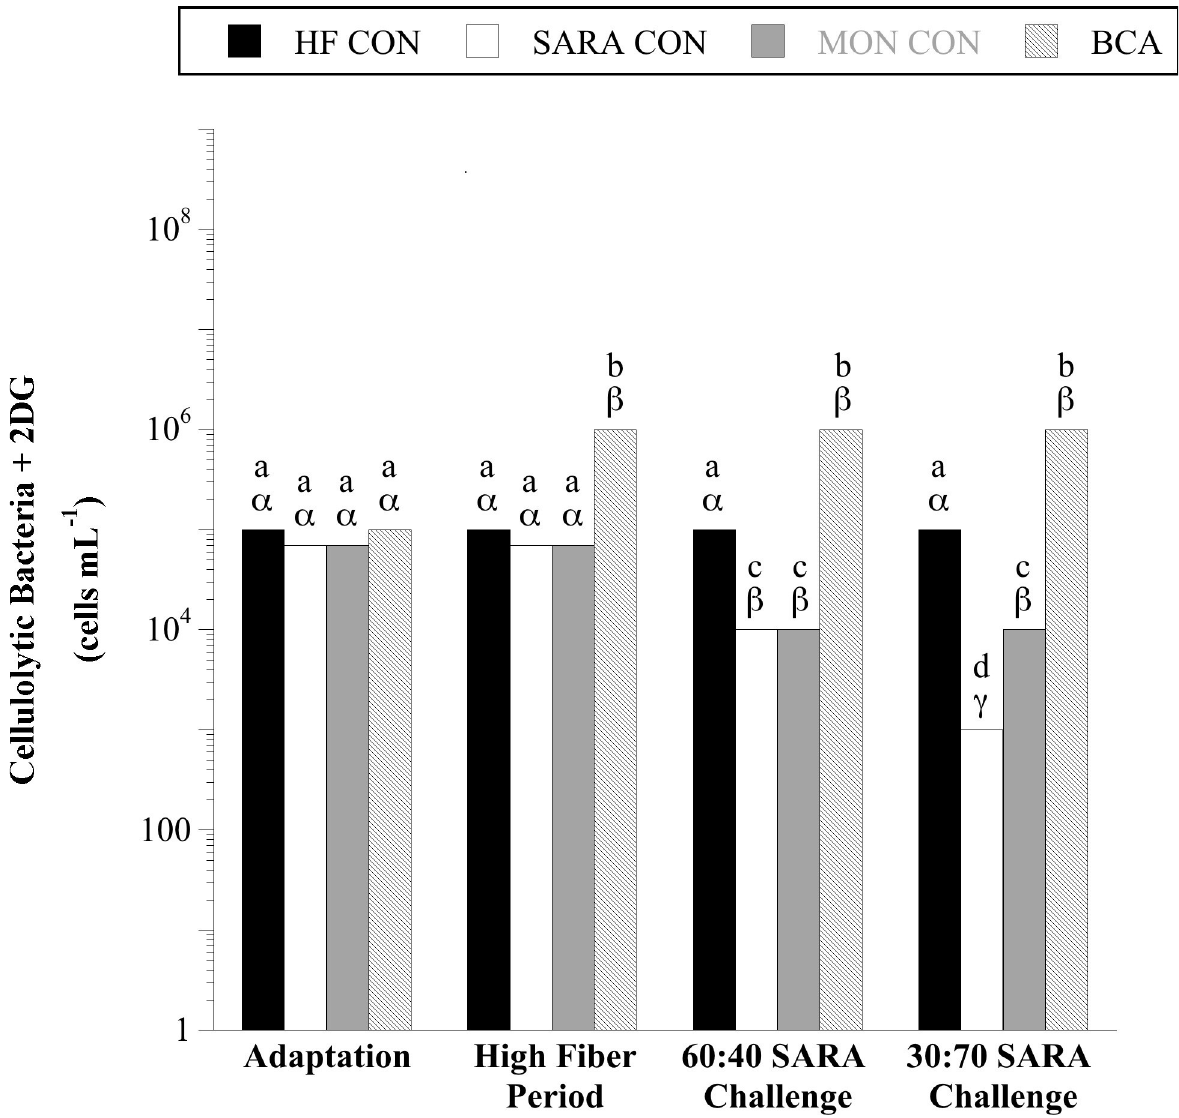
Fig 5. Effect of biochanin A on the viable number of 2-deoxy-D-glucose (2-DG) resistant cellulolytic bacteria in rumen fluid (4 h post- feeding). Holstein steers (n = 12) were blocked by weight into 1 of 4 treatments: High fiber control (HF CON; basal diet control, corn silage + dried distillers’ grain, to meet protein requirements; n = 3), SARA control (SARA CON; n = 3), SARA + monensin treatment (MON CON; 200 mg d -1 monensin; n = 3), or SARA + biochanin A treatment (BCA; 6 g d -1 biochanin A; n = 3). Rumen fluid samples were taken at the end of the adaptation period (100% basal diet), high fiber period (100% basal diet + treatments), 60:40 SARA challenge period (60% basal diet + 40% cracked corn + treatments), and 30:70 SARA challenge period (30% basal diet + 70% cracked corn + treatments) for 2-DG resistant cellulolytic bacterial enumeration. The enumerations were performed in anaerobic liquid media with cellulose (Whatman #1 filter paper strips) as the growth substrate with added 2-DG (6 mmol L -1 ). The tubes were incubated (39˚C, 10 d), and the final dilution exhibiting dissolution of cellulose (visual examination) was recorded as the viable number. Means lacking a common English letter are different within sample day ( P < 0.05). Means lacking a common Greek letter are different over sample days within treatment ( P < 0.05). Treatment: P < 0.0001, sample day: P < 0.0001, and treatment × sample day: P < 0.0001; Pooled SEM: Treatment = 0.1273, sample day = 0.0867, treatment × sample day = 0.1735 (log